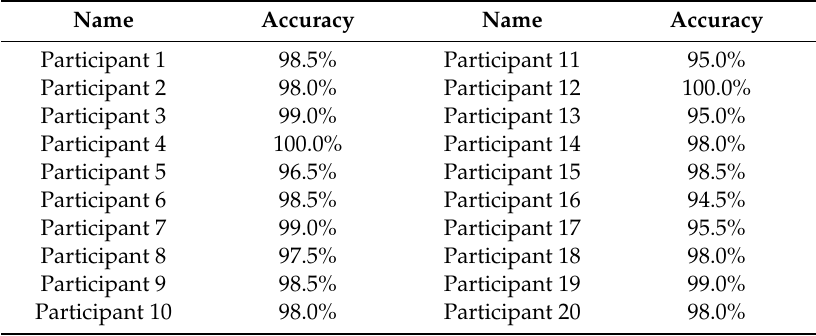
Table 9. The classification accuracy of 20 participants with the bilinear model.